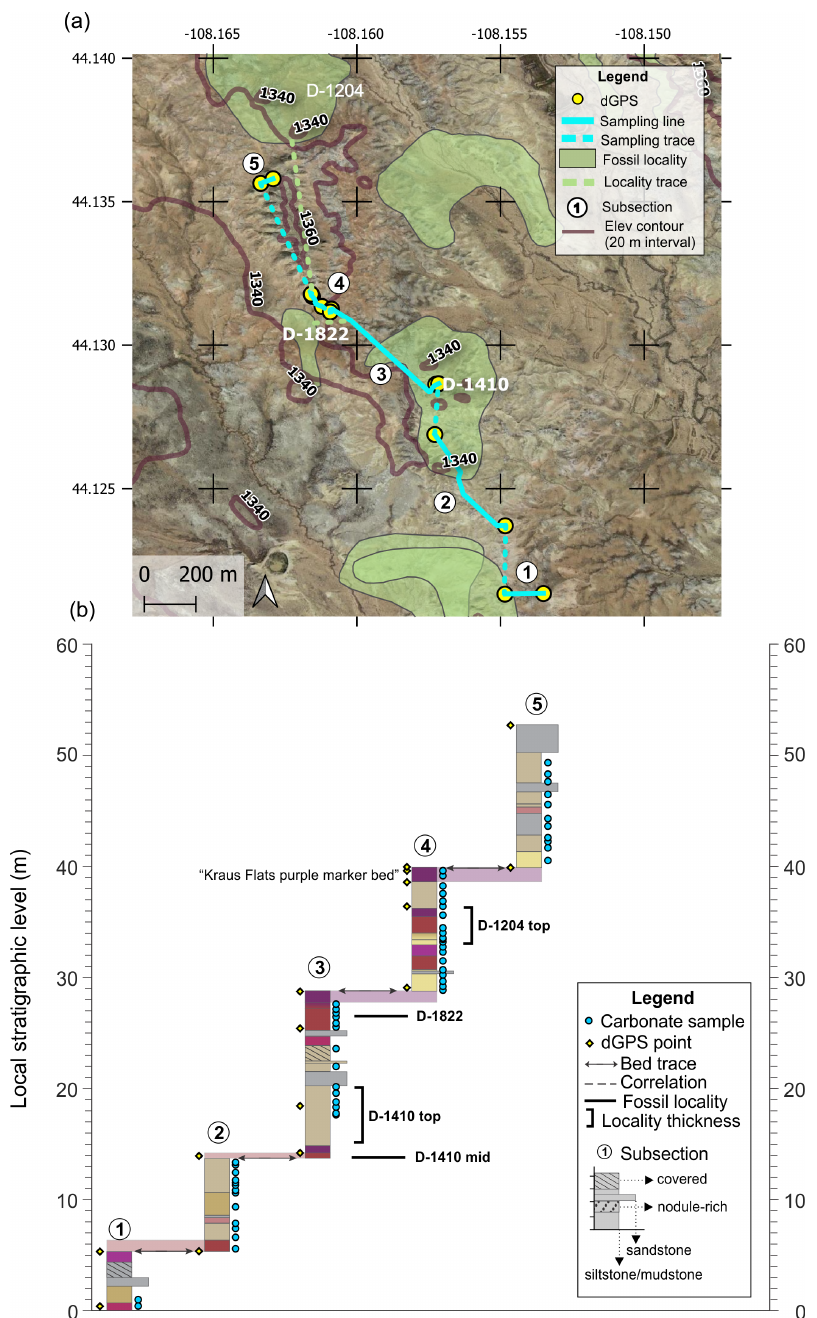
Figure A3. Kraus Flats section (a) map and (b) diagram showing sampling subsections, dGPS tie points, bed traces, and correlated fossil localities. Colored boxes in (b) represent the surface color of weathered rocks. Marker beds used to trace between subsections are shown in light shading with arrows along the bed surface used for tracing. Basemap source: Google Earth © 2021. A high-resolution map is available in the supplemental data repository (Widlansky et al.,